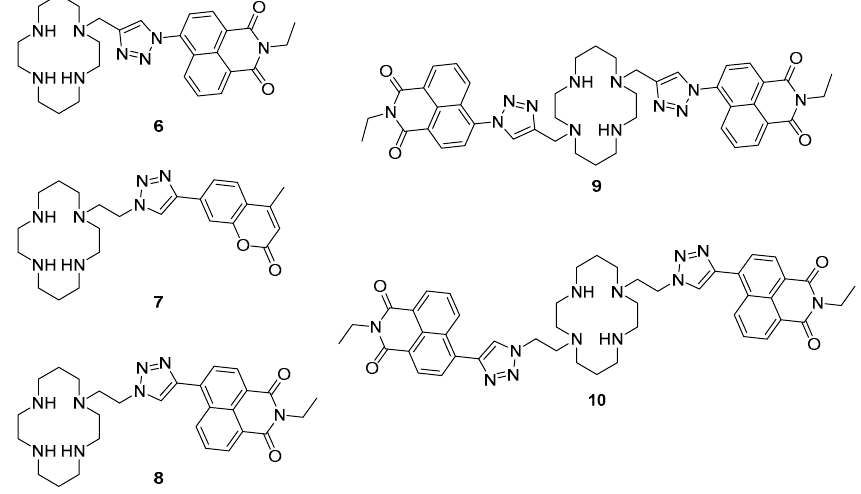
Figure 4. Cyclam-based metal ion probes that incorporate a ‘click’-derived triazole as both a linker between receptor and reporter, and an additional metal-binding ligand (i.e., part of the receptor). The simple naphthalimide systems 6 and 8 respond to Zn 2+ while coumarin 7 is a Cu 2+ /Hg 2+ probe. The bis-naphthalimides 9 and 10 are also ‘off-on’ probes for Zn 2+ , but their fluorescence properties display markedly different solvent-dependence. Note the difference in triazole connectivity between 6 and 9 in which the naphthalimide is attached to triazole N 1, versus 7 , 8 and 10 , in which the fluorophore is linked to C 4 of the triazole.